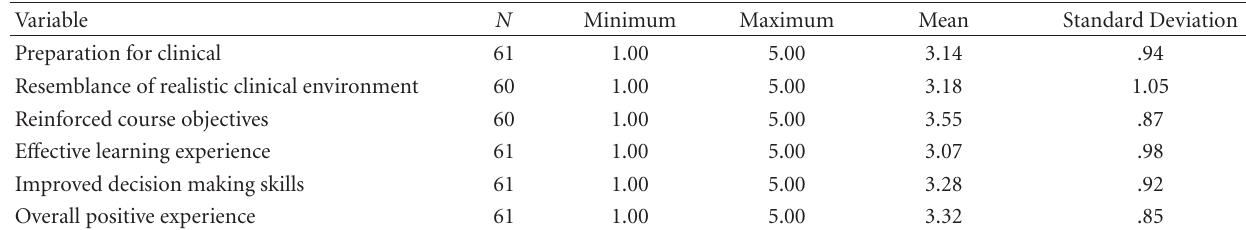
Table 3: Survey responses ( n =